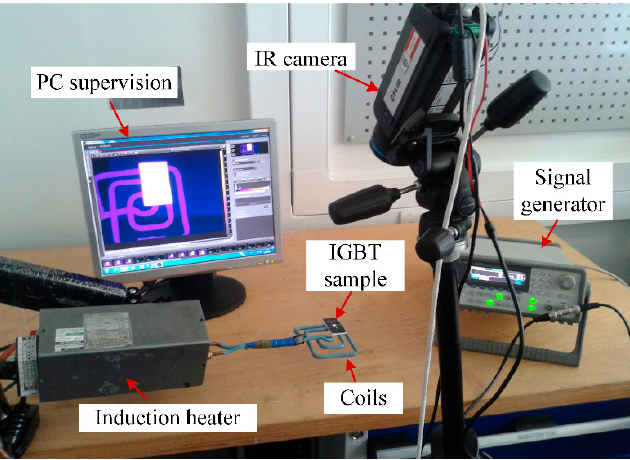
Figure 11. Configuration of the experimental ECPT system.